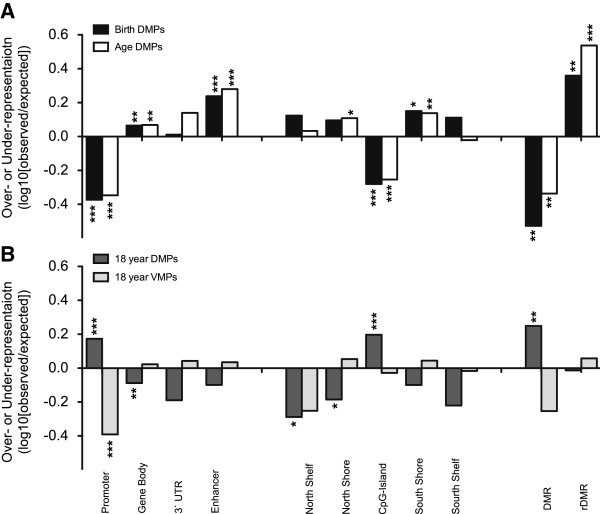
Genomic and sequence context of differentially methylated probes (DMPs). Enrichment or depletion of DMPs displayed as the log10 of the observed/expected frequencies for each category with significance from hypergeometric test results displayed as *P < 10-5, **P < 10-10, and ***P < 10-20. (A) Genomic enrichment distribution of 1,555 birth DMPs (black) and 3,244 age DMPs (white) showed similar profiles. (B) Top 1,500 probes ranked by odds of differential methylation at 18 years (18-year DMPs; dark grey) and the top 1,500 most variable methylated probes (18-year VMPs; light grey) showed distinct enrichment profiles, with the 18-year DMPs showing the opposite enrichment to the birth DMPs and age DMPs.